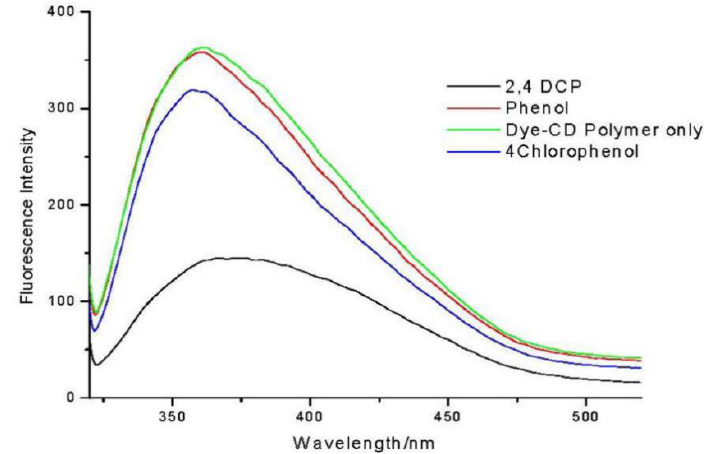
Figure 23. Sensor synthesis (up) and sensitivity factor against phenol, 4-chlorophenol and 2,4-dichlorophenol (down). Reuse (down) permitted by the Creative Common CC BY license from Ncube, P.; Krause, R.W.; Mamba, B.B. Fluorescent Sensing of Chlorophenols in Water Using an Azo Dye Modified β -Cyclodextrin Polymer. Sensors 2011 , 11 , 4598–4608, doi:10.3390/s110504598.